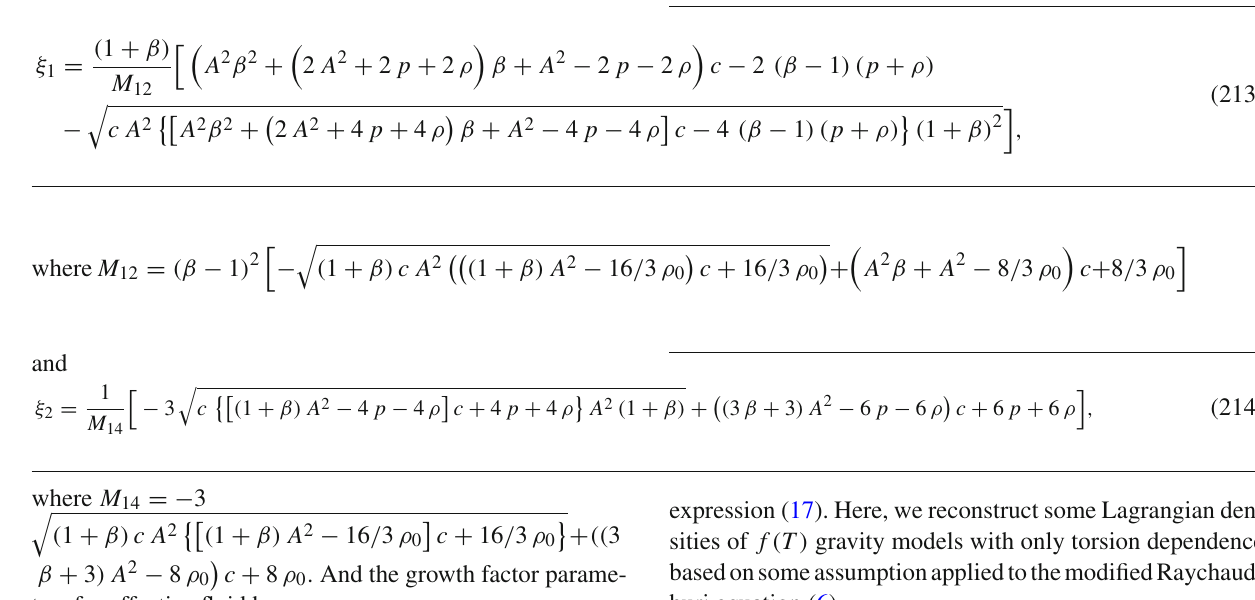
Fig. 17 w ef f ( 1 , 2 ) versus a for radiation-dust-torsion system for MGCG for β = 4, c = 1 . 2 and A =